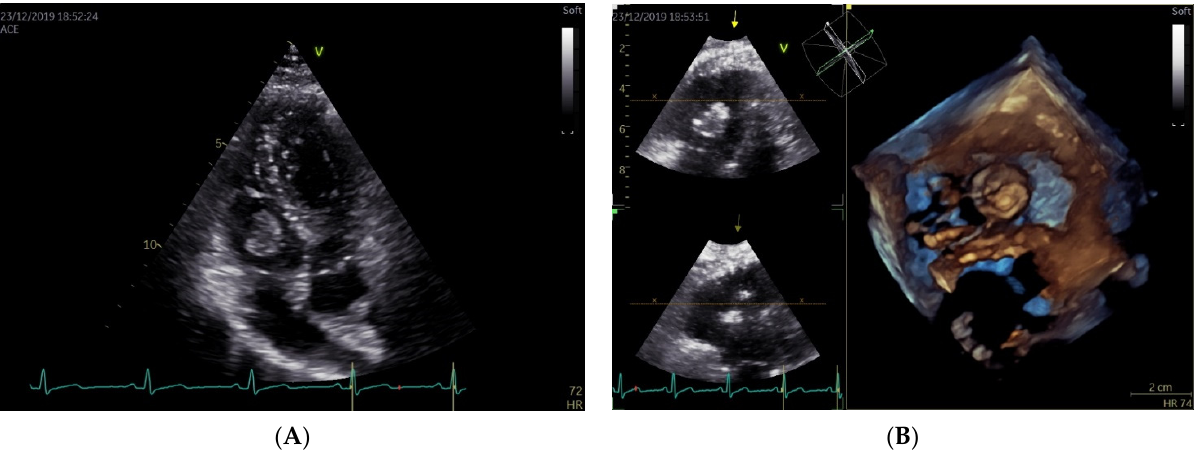
Figure 1. Standard ( A ) and 3D echocardiographic assessment ( B ) of right-side intracardiac mass.